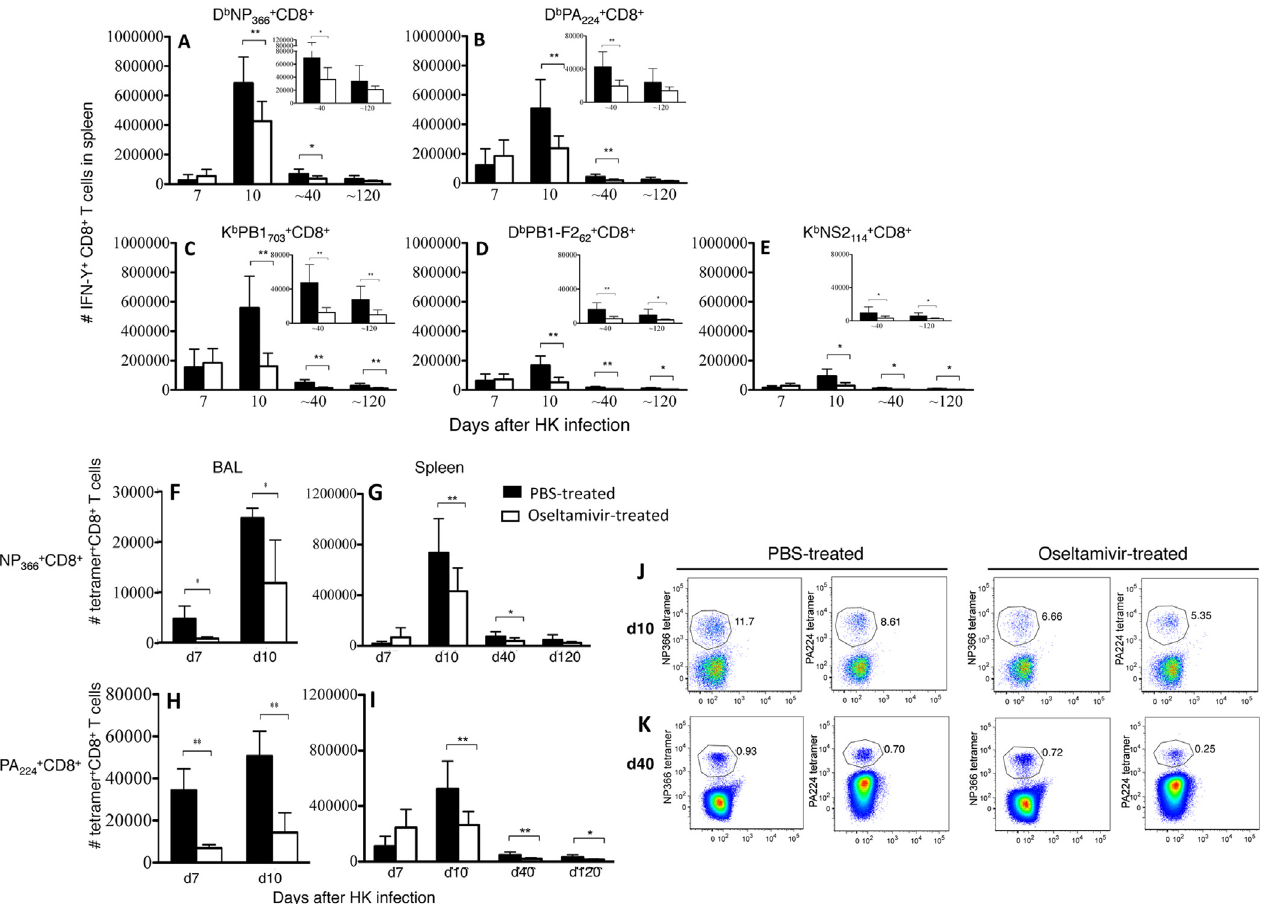
Fig 4. Oseltamivir treatment decreases the magnitude of the effector influenza-specific CD8 + T cell responses. BL/6 mice administered with oseltamivir or PBS were assessed for CD8 + T cell responses to the influenza A viral epitopes (A) D b NP 366 , (B) D b PA 224 , (C) K b PB1 703-711 , (D) D b PB1-F2 62-70 and (E) K b NS2 114-121 by intracellular IFN- γ staining after a five hour stimulation of splenocytes with cognate peptide. Data represent 9 – 10 mice per group, analysed over two independent experiments. Epitope-specific CD8 + T cells directed at (FG) D b NP 366 , (HI) D b PA 224 were enumerated by tetramer staining in both spleen (GI) and at the site of infection (FH). Data represent 9 – 10 mice per group, analysed over two independent experiments. The mean and standard deviation is shown. (JK) Representative dotplots for the D b NP 366+ CD8 + and D b PA 224+ CD8 + T cell populations on d10 (acute phase) and d40 (memory) are shown; populations are gated on CD8 + T cells. The mean and standard deviation is shown. * P < 0.05; ** P <